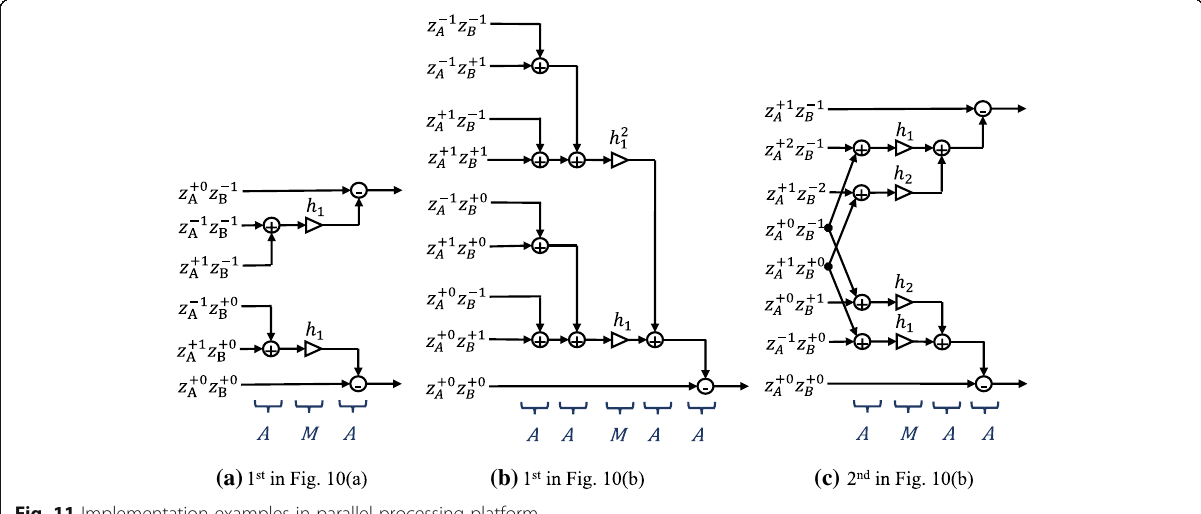
Fig. 11 Implementation examples in parallel processing